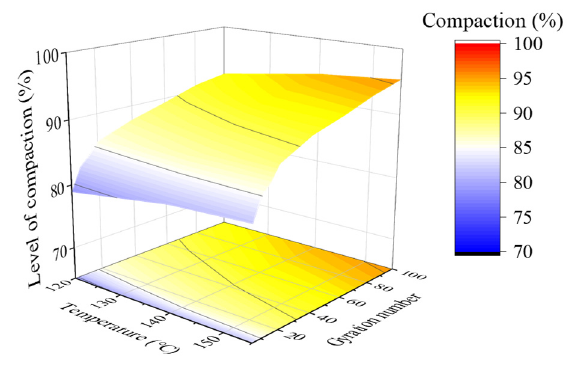
Figure 7. Surface plots of the variation in compaction level versus gyration number for the